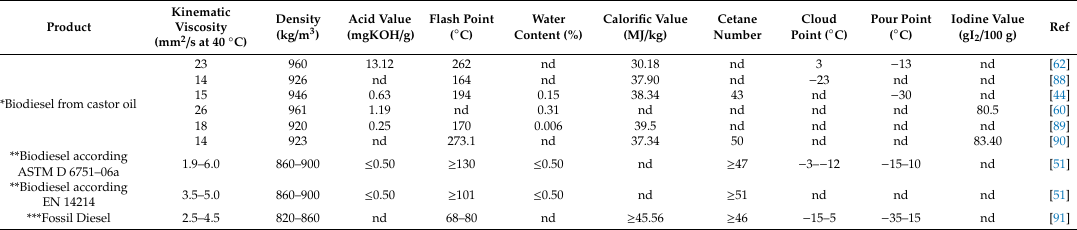
Table 7. Main characteristics of biodiesel produced using castor oil as a